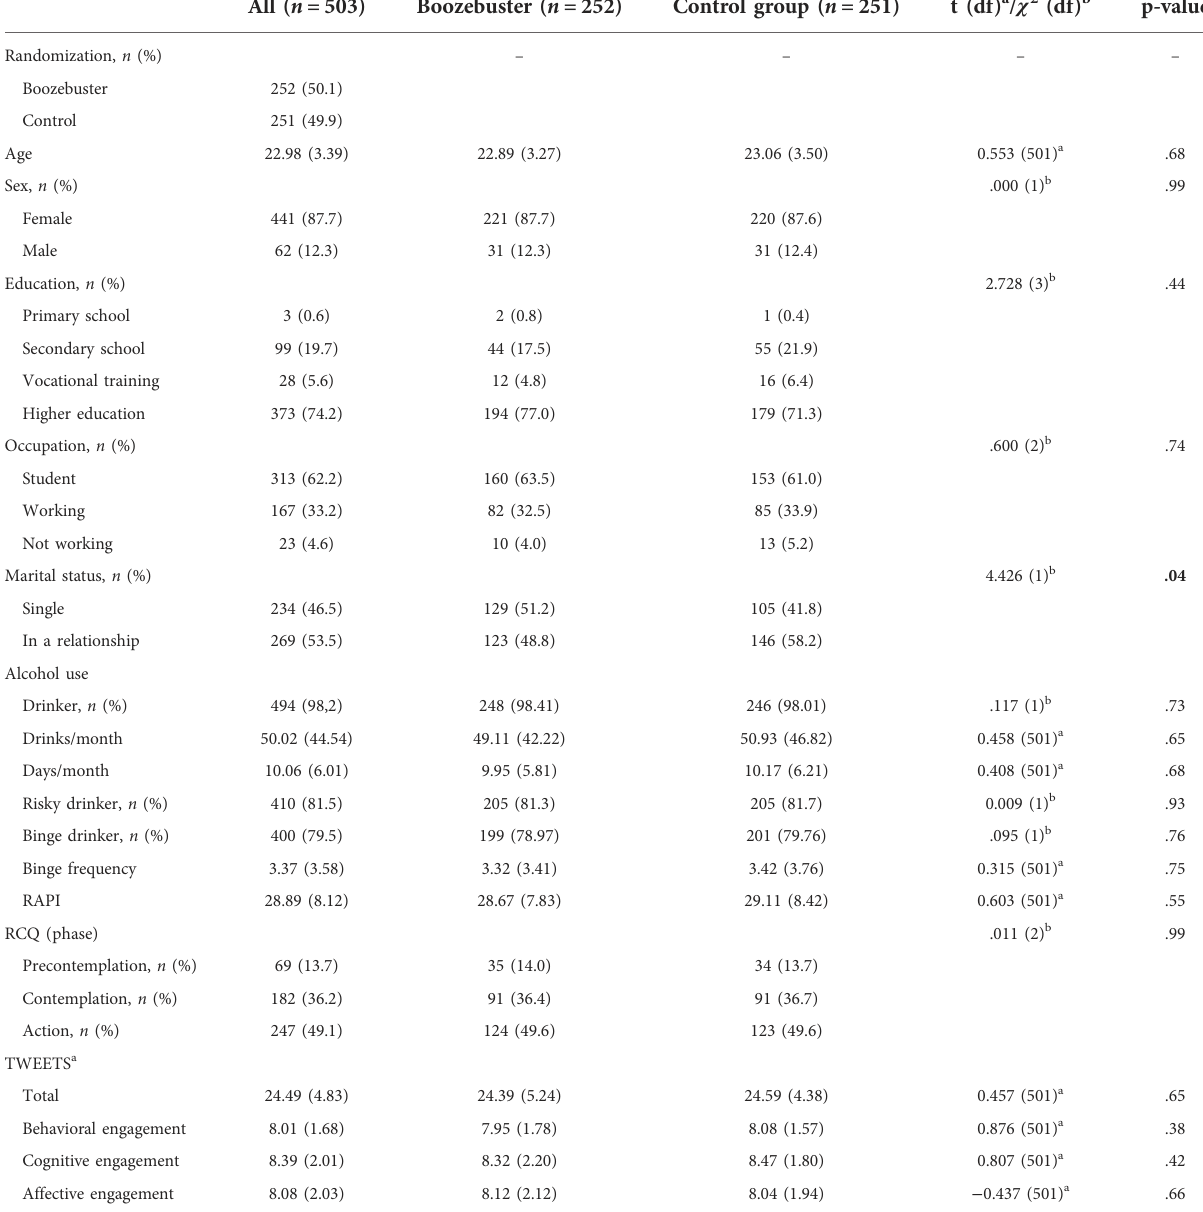
TABLE 2 Baseline characteristics of participants who were randomized after completing the baseline